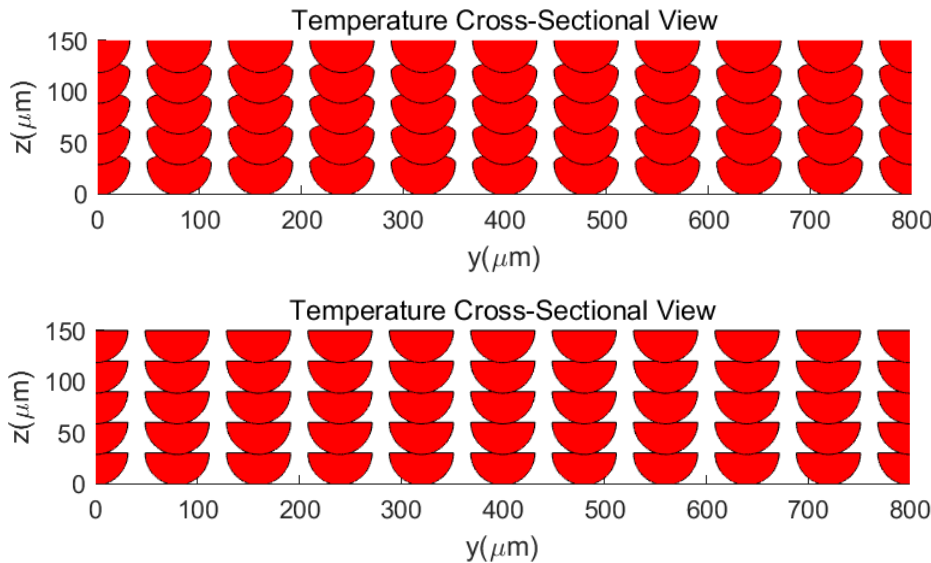
Figure 7. Overlapping patterns of molten pools considering cap area ( top ) and without considering cap area ( bottom ). Red portion represents the molten pool cross sections, white portion represents the lack-of-fusion area. Laser power = 150 W, Scanning speed = 550 mm/s, Hatch = 80 μm , Layer thickness = 30 μm .